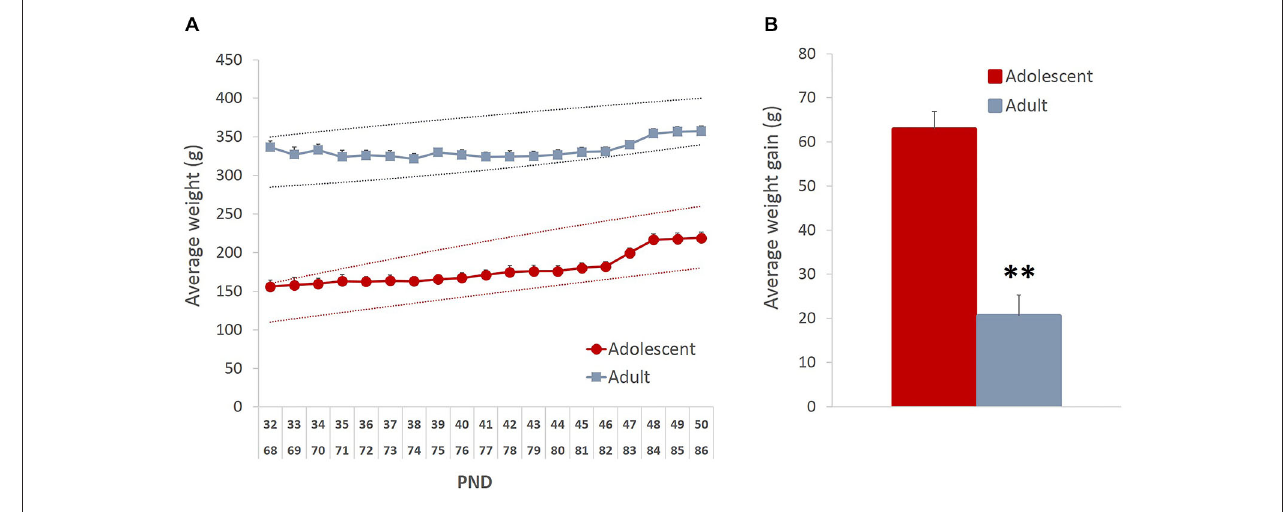
increase in weight by the end of the study. The dashed lines represent the approximate normal growth rate boundaries provided by Charles River Laboratories. (B) As expected, the average weight gain in adolescent animals was higher than in adults. Line and bar graphs represent group averages + SEM. ** p < 0.01.